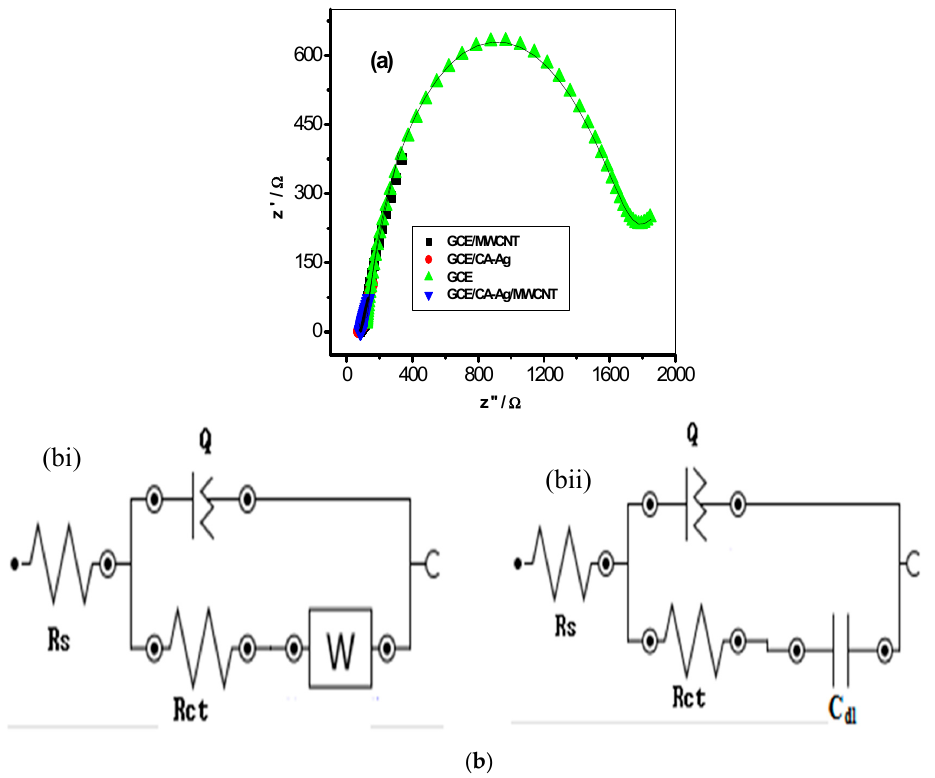
Figure 7. Typical Nyquist plots ( a ) obtained for the electrodes in 5 mM Fe(CN)6]4 − /[Fe(CN)6]3 − solution prepared in 0.1 M PBS (pH 7) at a fixed potential of 0.2 V (vs. Ag|AgCl, saturated KCl) ( b ( i , ii )) represent the circuits used in the fitting of the EIS data. Table 1. Impedance data obtained for the bare GCE and the modified electrodes in 5 mM Fe(CN) 6 ] 4 − /[Fe(CN) 6 ] 3 − solution at 0.2 V (vs. Ag|AgCl saturated KCl). All values were obtained from the fitted impedance spectra. The values in parentheses are percent errors of data fitting. Electrodes